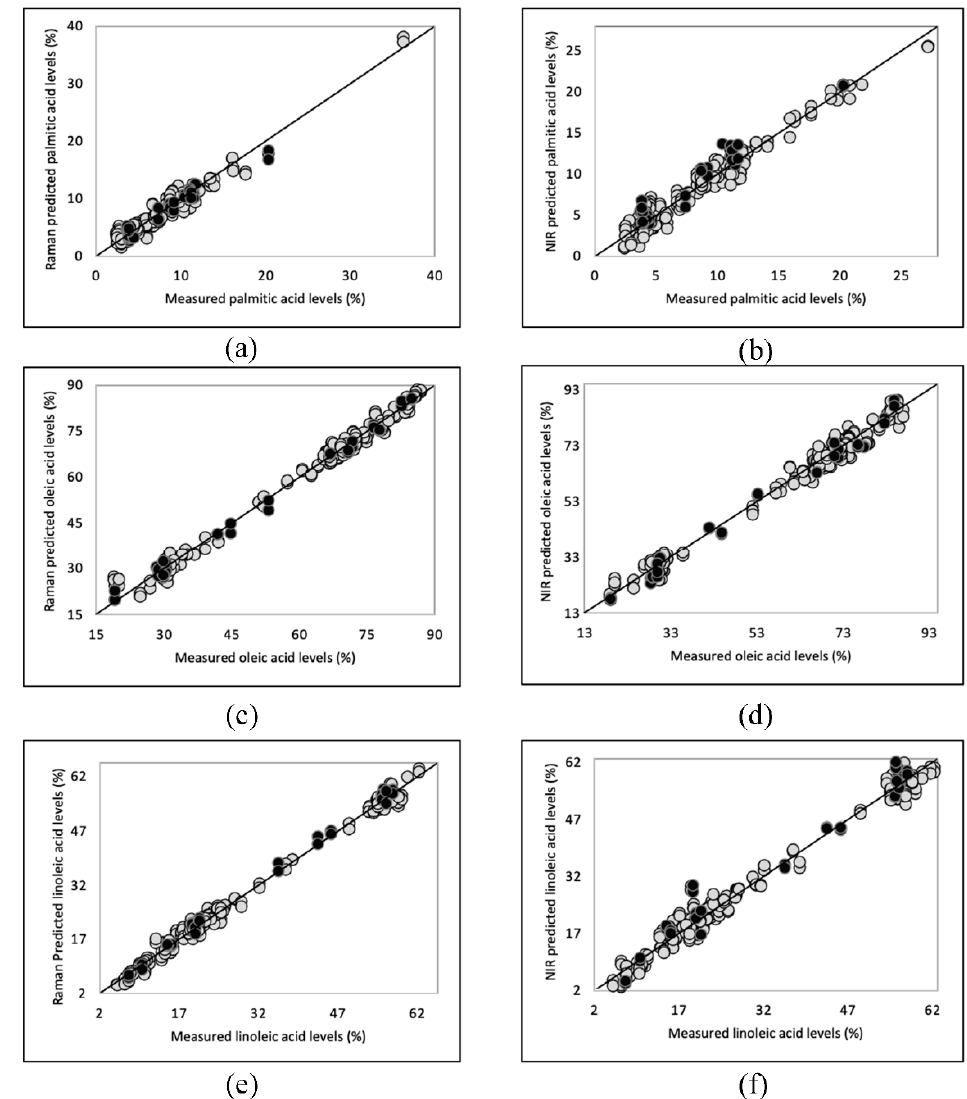
Figure 5. PLSR calibration and validation plots for main fatty acids, palmitic acid ( a , b ), oleic acid ( c , d ), and linoleic acid ( e , f ) in potato chip samples utilizing Raman and NIR data